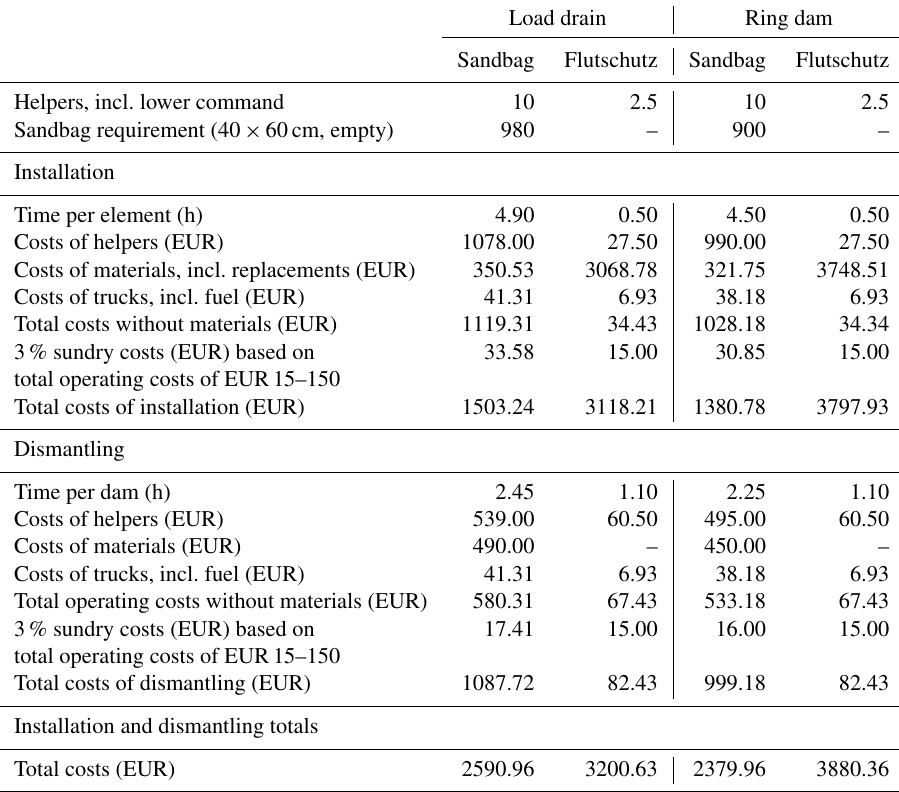
Table 6. Comparison of the costs of the installation and dismantling of sandbag systems and SBRSs – load drain (case 2) and ring dam (case 3).